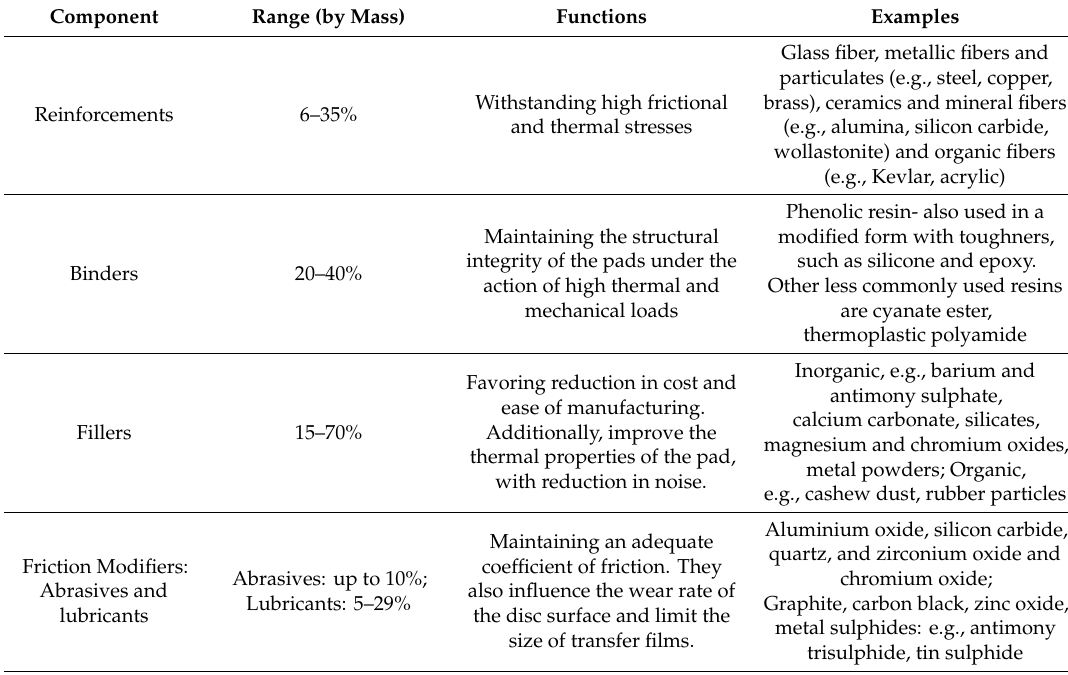
Table 2. Brake Pads: main ingredients